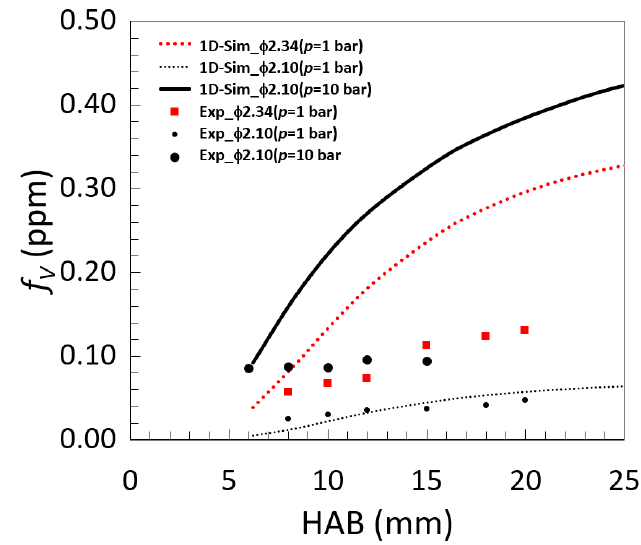
Figure 10. Comparison between the measured centerline f V (ppm) profiles [6] (symbols) and the 1D simulated ones (lines) of C 2 H 4 /air flames at p = 1.01 (dotted lines) and 10 (solid line) bar for ϕ = 2.1 (in black) and at p = 1.01 bar for ϕ = 2.34 (in red).